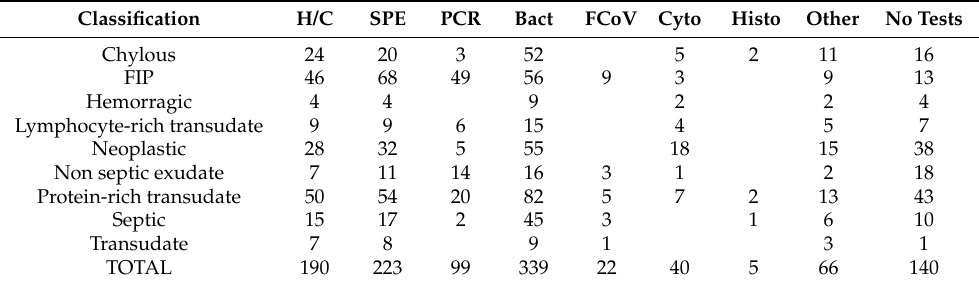
Table 4. Number and distribution of additional tests